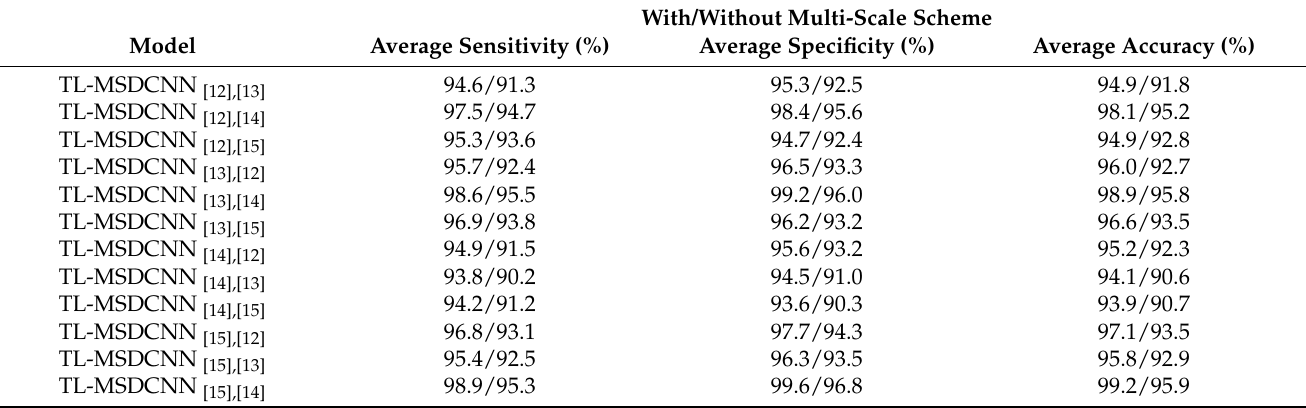
Table 7. Performance of the 12 target models using TL-MSDCNN with and without multi- scale